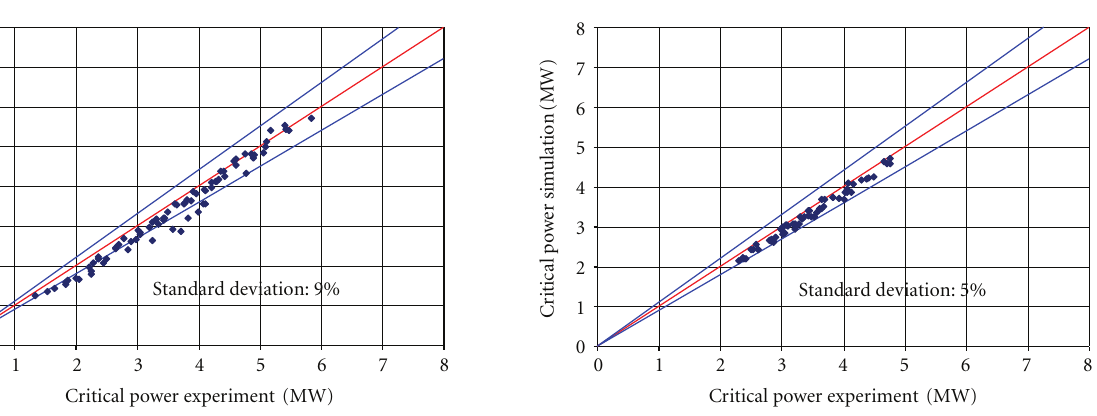
Figure 20: Measured and simulated critical power values for assem- bly A4.